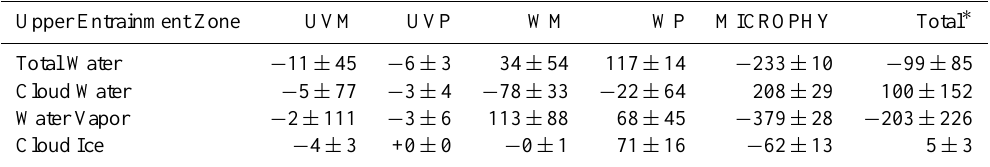
Table 3. Mean ( ± one standard deviation) contribution of advection and microphysics to time and horizontally averaged water content tendencies in the upper entrainment zone, in units of gm − 2 day − 1 . Advection by the mean flow is calculated from 15-min averaged fields. Eddies are defined as deviations from the 15-min averages. Total ∗ is the sum of advection terms plus microphysics and is not exactly equal to total tendency due to errors incurred by calculating the advection terms offline (see discussion of Fig. 13).